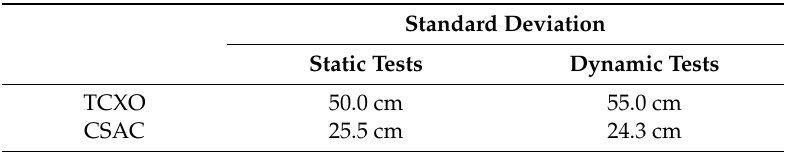
Figure 13. Height estimation for: static ( top ); and dynamic ( bottom ) acquisitions. Table 8. Static and dynamic tests—height error standard deviation.